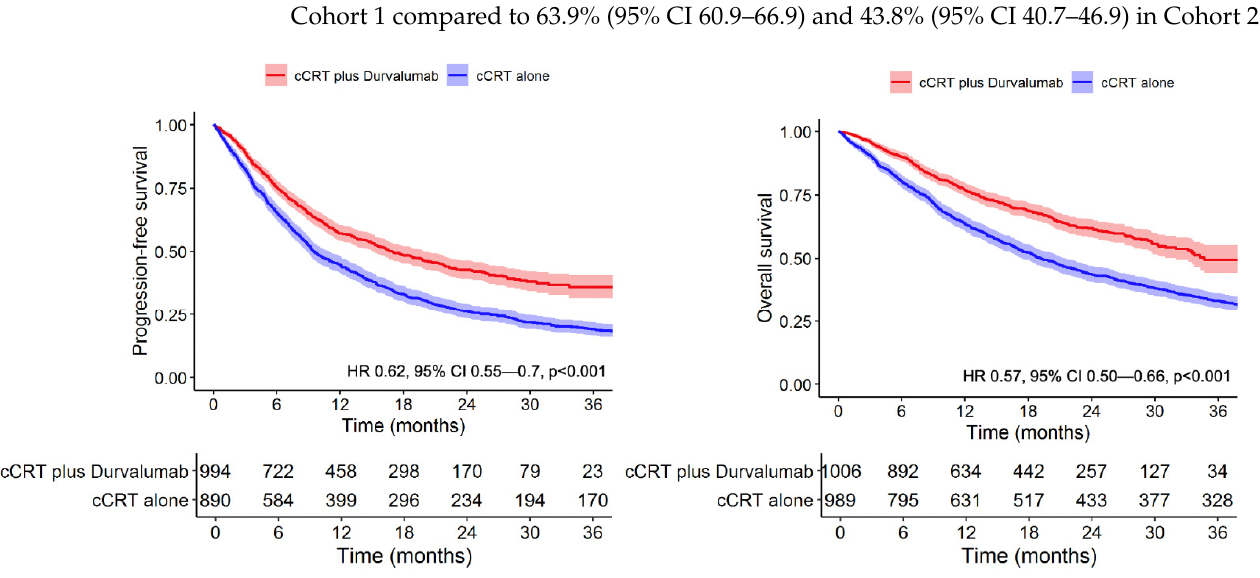
Figure 1. Adjuvant durvalumab significantly extends progression-free and overall survival in Vet- erans with stage III NSCLC.